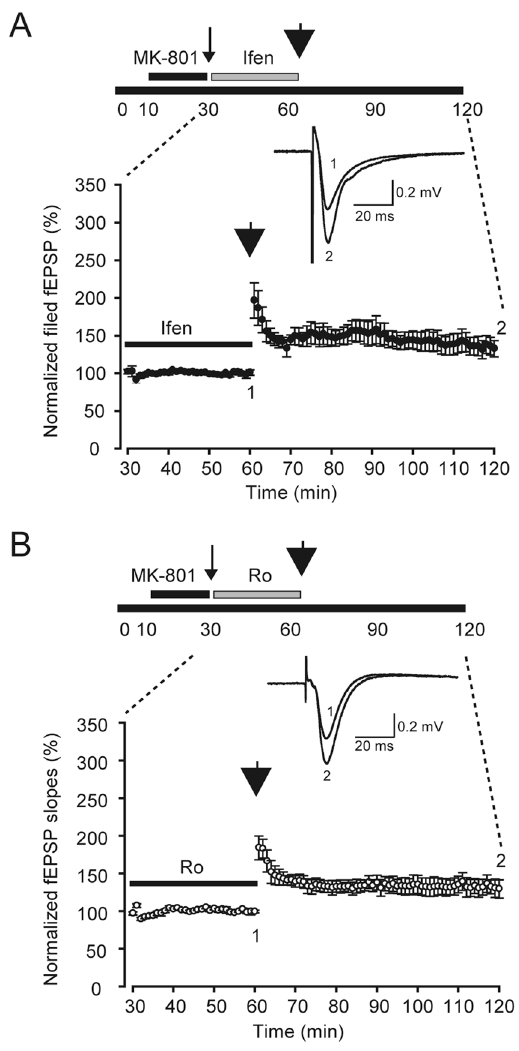
Figure 2. LTP when S-NMDARs were inhibited. LTP was induced in the presence of ifenprodil ( A , closed circles, n = 6) or Ro ( B , open circles, n = 5). LFS and 3-train HFS are represented by thin and thick arrow heads, respectively. Ifenprodil (Ifen, 10 μ M) or Ro25-6981 (Ro, 3 μ M) application is indicated by the horizontal black bar. Insets: traces recorded at various time